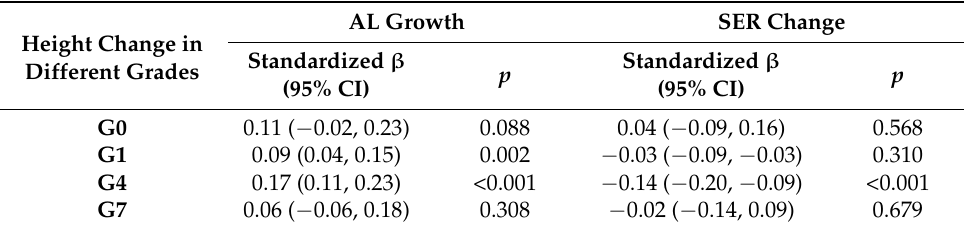
Table 3. Linear regression analysis for the association of the height and AL growth and SER change for PNM children.